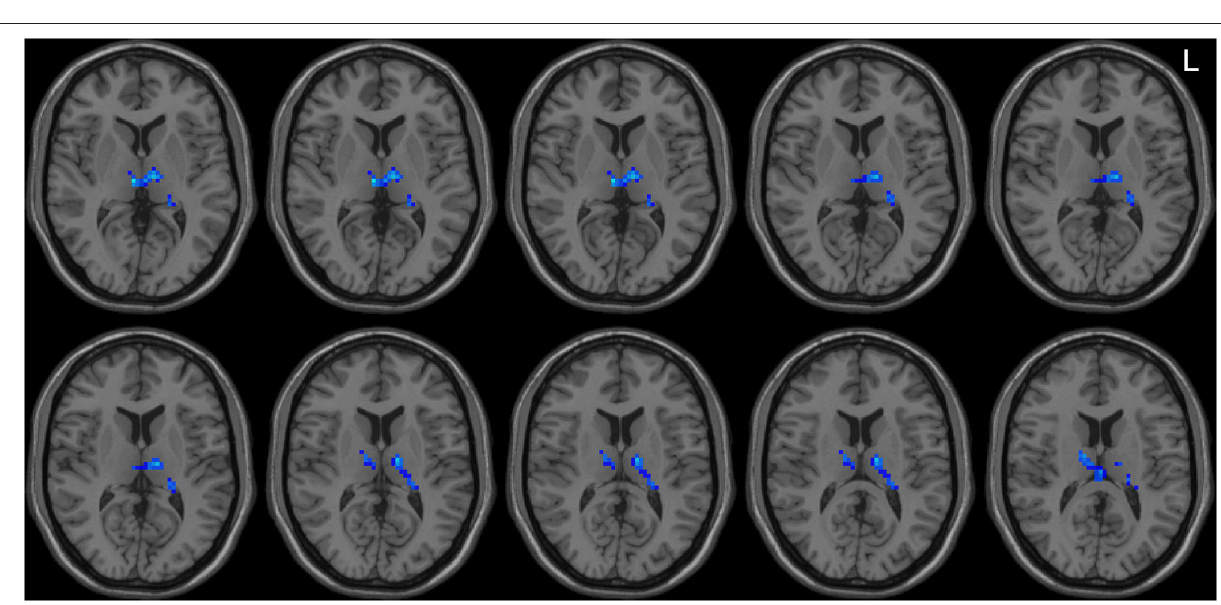
FIGURE 2 | Decreased ALFF in bilateral thalamus in the LPD patients compared with the controls. L indicates the left